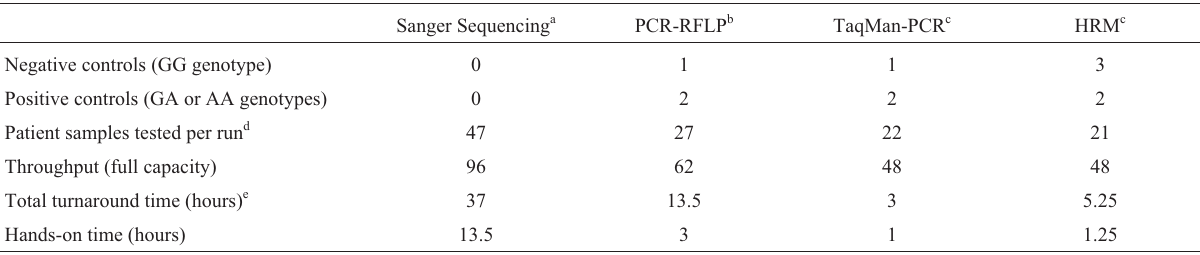
Table 1 - Features of each TP53 -p.R337H genotyping